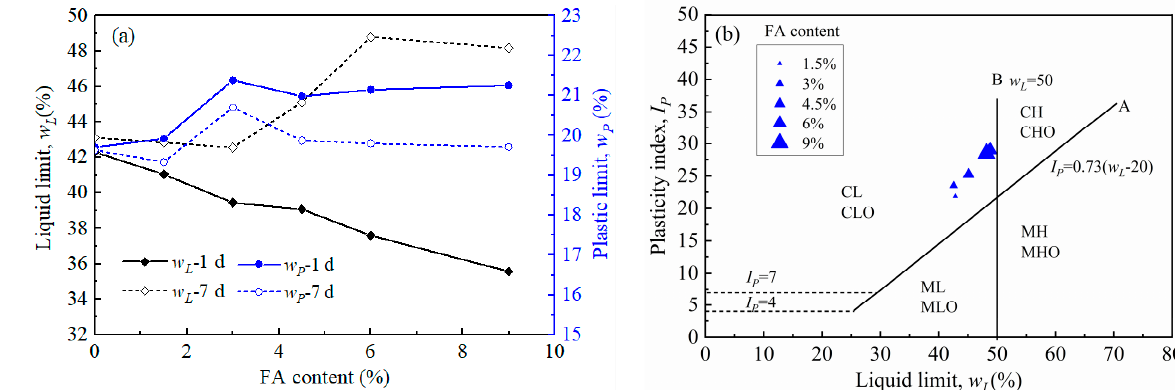
Figure 2. Effect of FA on the consistency limit of sludge: ( a ) liquid limit and plastic limit; ( b ) plastic- ity diagram.